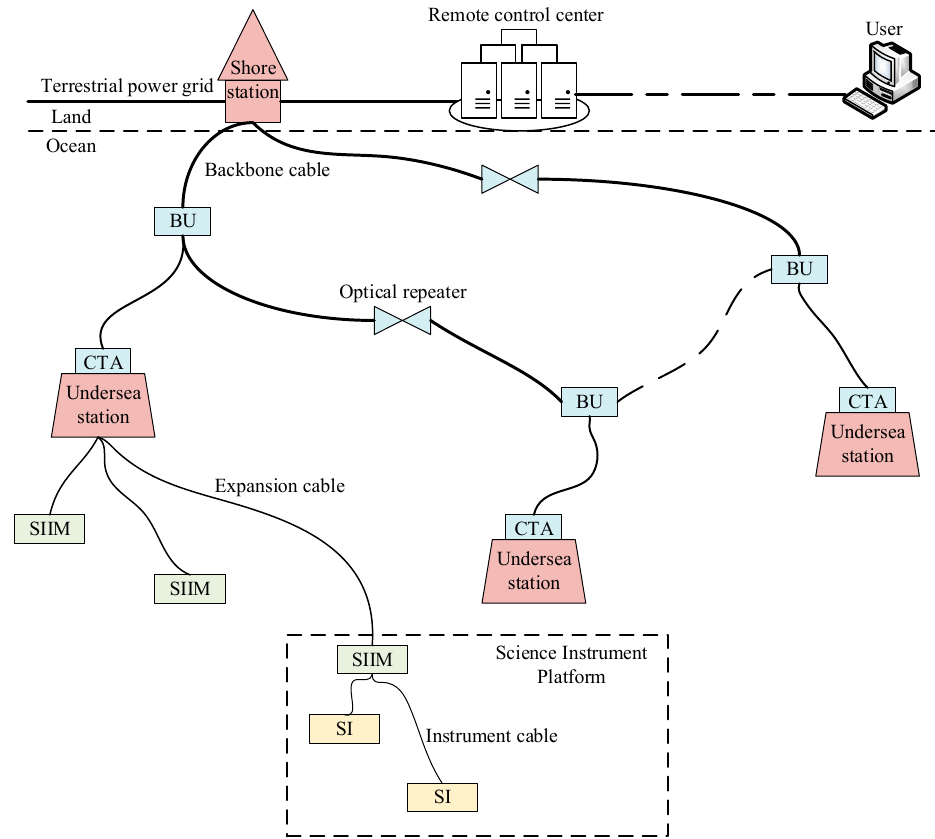
Figure 1. A typical system diagram of scientific cabled seafloor observatories (CSOs).